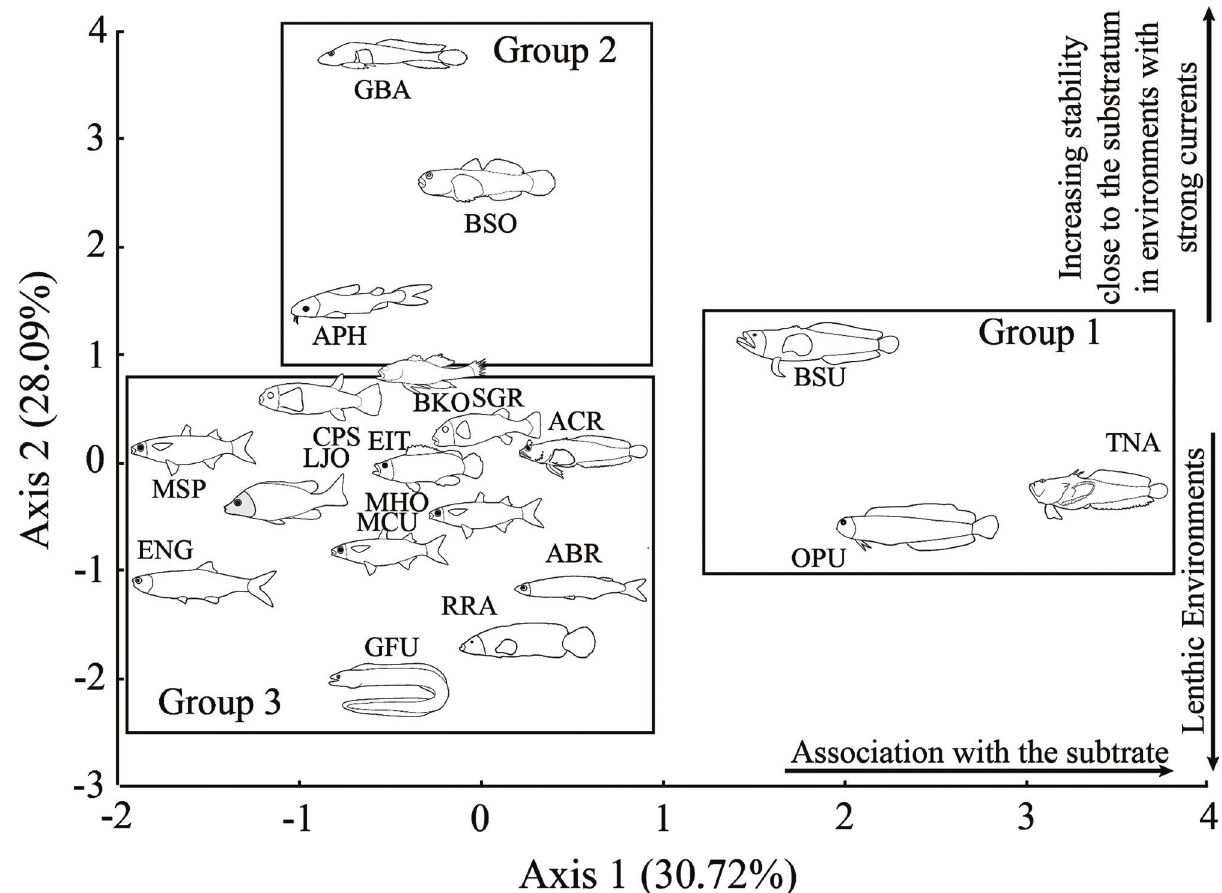
Fig. 3. Principal Components Analysis (PCA) of six ecomorphological indices related to the position of the species in the water column, based on the morphometric measurements of 19 fish species collected from tide pools on the Amazonian Coastal Zone in 2011. Hypotheses concerning the interpretation of the ecomorphological indices highly correlated with the principal axes. Codes: Atherinella cf. brasiliensis (ABR); Amphichthys cryptocentrus (ACR); Amphiarius phrygiatus (APH); Bathygobius soporator (BSO); Batrachoides surinamensis (BSU); Butis koilomatodon (BKO); Colomesus psittacus (CPS); Epinephelus itajara (EIT); Engraulidae gen. (ENG); Gobiesox barbatulus (GBA); Gymnothorax aff. funebris (GFU); Lutjanus jocu (LJO); Mugil aff. curema (MCU); Mugil aff. hospes (MHO); Mugil sp. (MSP); Omobranchus punctatus (OPU); Rypticus randalli (RRA); Sphoeroides greeleyi (SGR); Thalassophryne nattereri